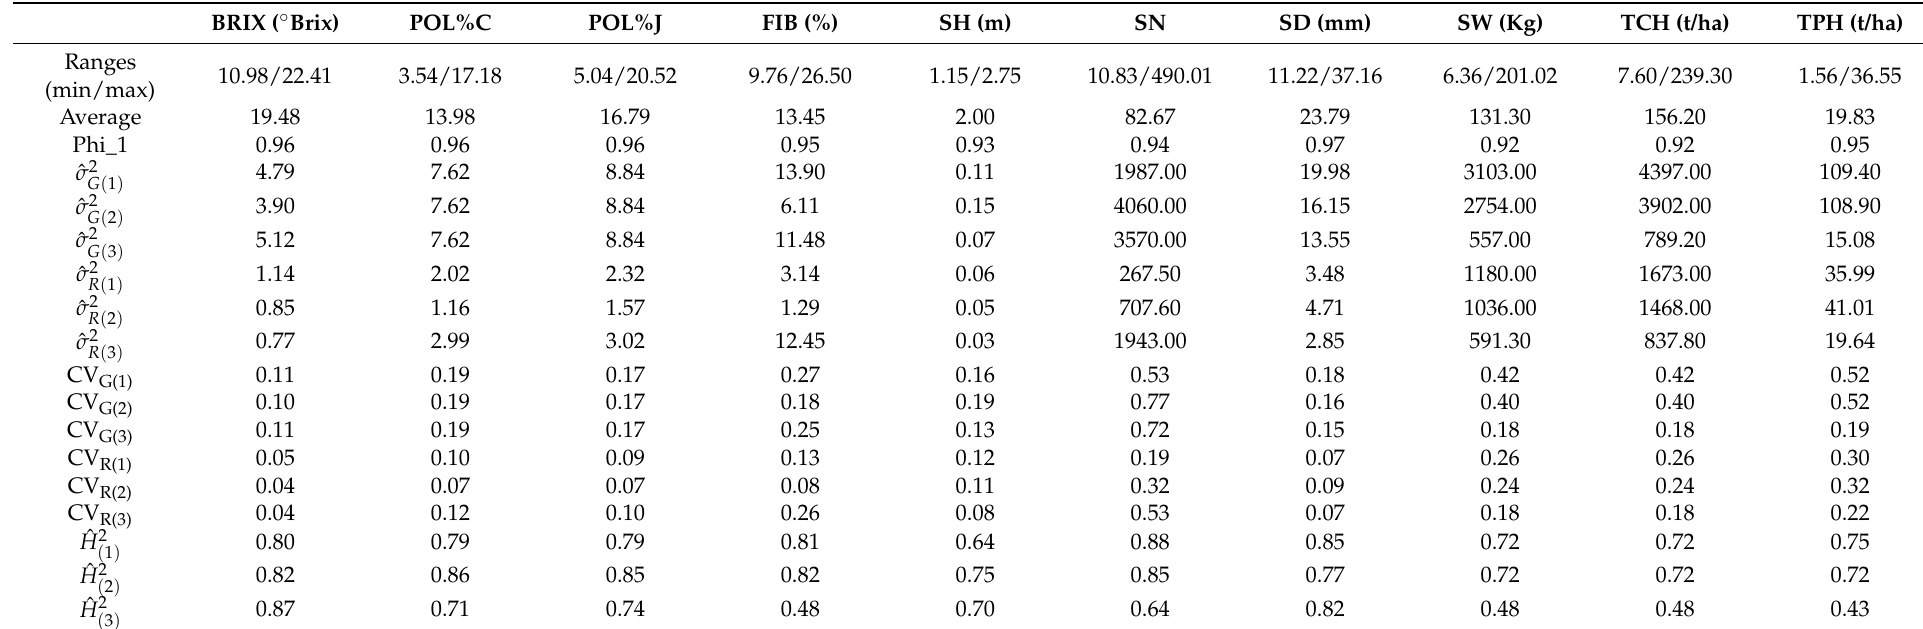
Table 1. Ranges, averages, estimates of components of genetic (ˆ σ 2 ) and residual (ˆ σ 2 ) variances, coefficient of genotypic (CV G ) and residual (CV R ) variation, and broad-sense heritability on R G an individual-plant basis ( H 2 ) for BRIX (in ◦ Brix), sucrose content of the cane (POL%C, in %), sucrose content of the juice (POL%J, in %), fiber content (FIB, in %), stalk height (SH, in m), stalk number (SN), stalk diameter (SD, in mm), stalk weight of the plot (SW, in kg), cane yield (TCH, in t/ha), and sucrose yield (TPH, in t/ha) for BPSG over three harvest years (2014(1), 2015(2), and